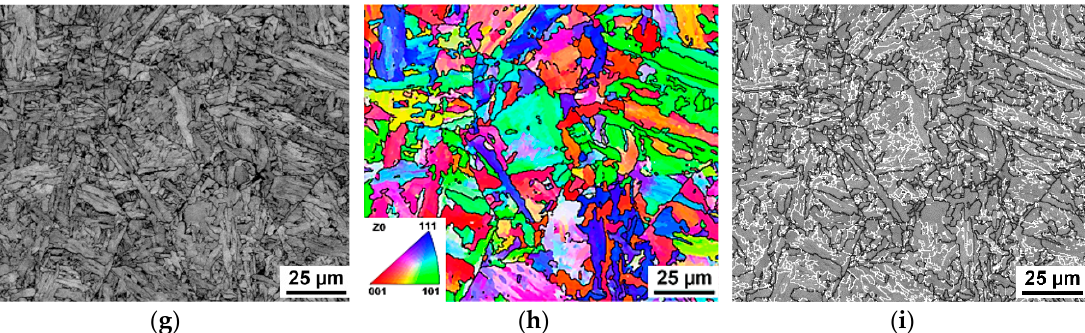
Figure 14. EBSD maps of TC# samples with deformation and cooling rates of ( a, b, c ) 2 °C/s, ( d, e, f ) 5 °C/s, and ( g, h, i ) 15 °C/s. ( a , d , g ) Image quality maps; ( b , e , h ) inverse pole figure maps; ( c , f , i ) grain boundaries of misorientation angle >15° (black) and 2–15° (blue).